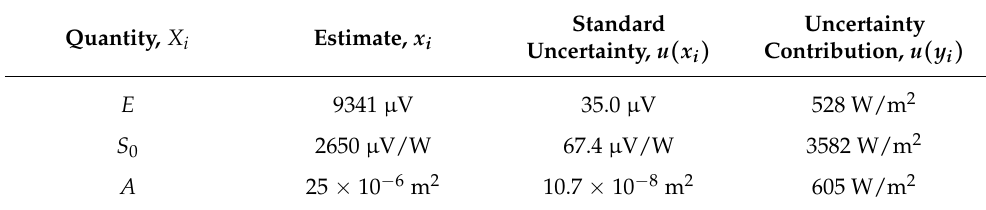
Table 4. Uncertainty budget for heat flux per unit area.